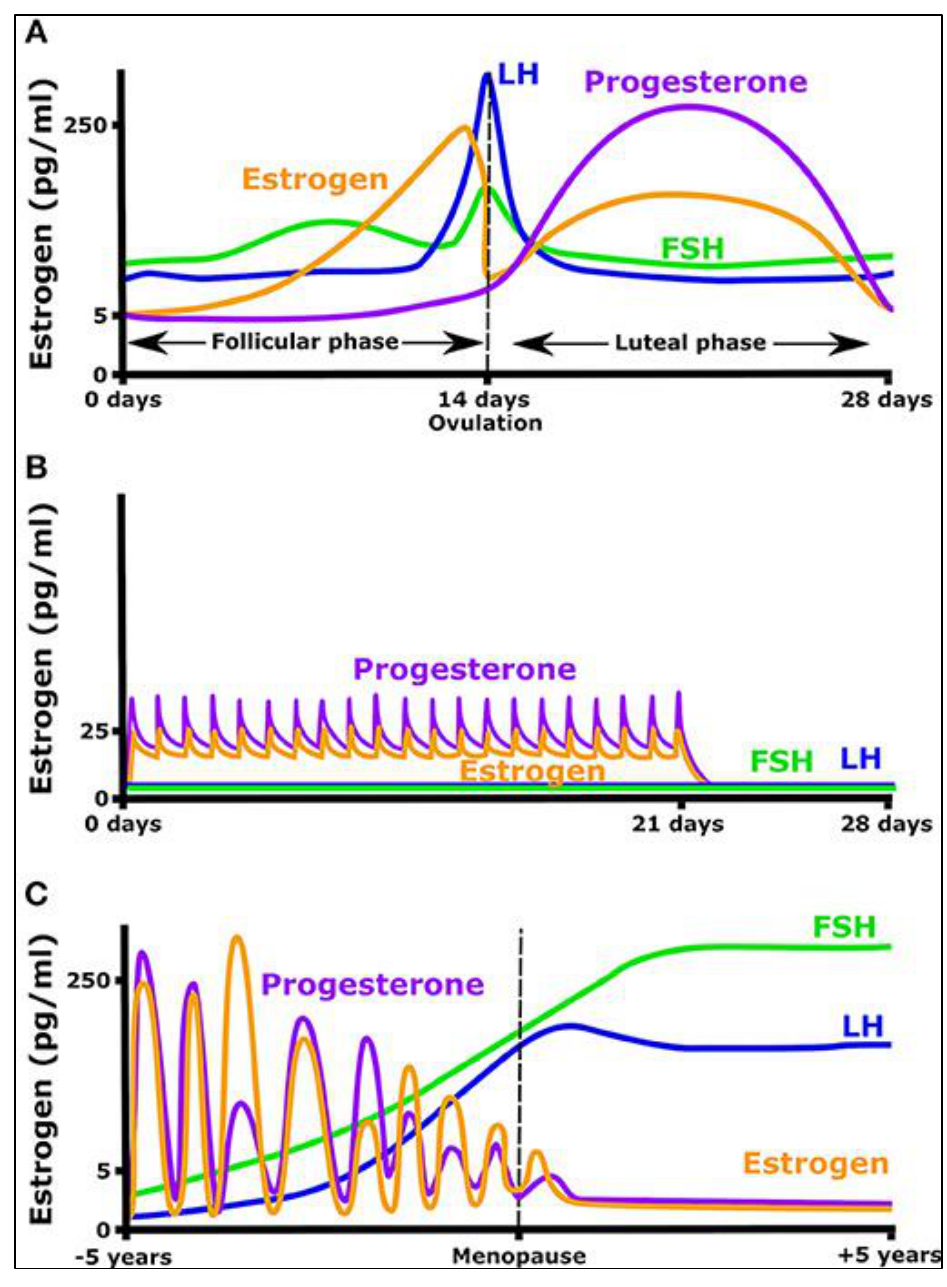
Figure 3. Hormonal changes observed during ( A ) a normal menstrual cycle, ( B ) when taking an oral contraceptive containing both progesterone and estrogen, and ( C ) in the years before and after menopause. Various factors such as pharmacological agents, diseases, or age (a physiological factor) can change the pattern of infradian variations in the analytes; reprinted from Ref. [94].